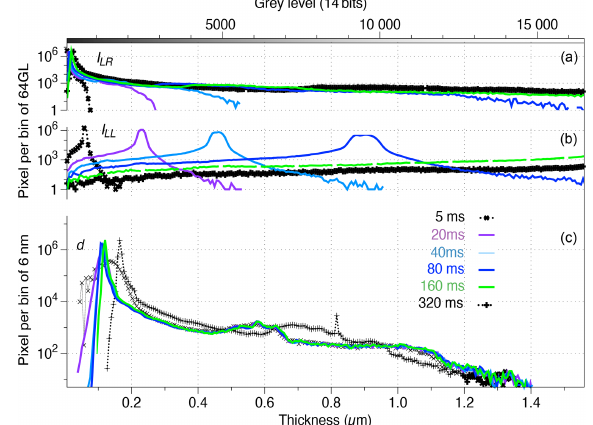
Figure 3. Histograms (bins of 64 grey levels (top) and 6nm (bot- tom)) of the same field of view as in Fig. 2, captured with green monochromatic light λ = 561nm in right circular polarization (a) , left circular polarization (b) and the resulting thickness using Eq. (2) (c) at different exposure times (black with plus signs: 5ms, purple: 20ms, light blue: 40ms, blue: 80ms, green: 160ms, and black with crosses: 320ms).